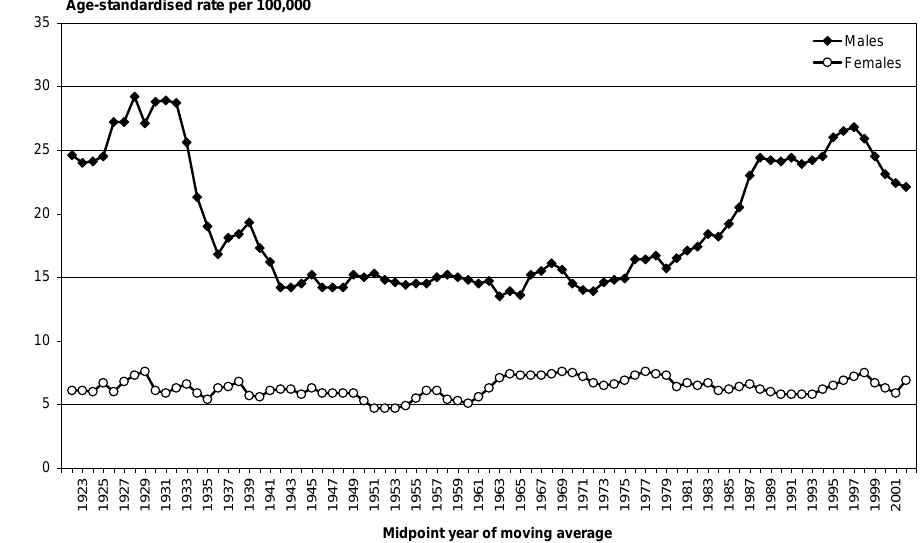
FIGURE 2. Death from suicide in New Zealand, by sex, 1921–2003. Source : New Zealand Health Information